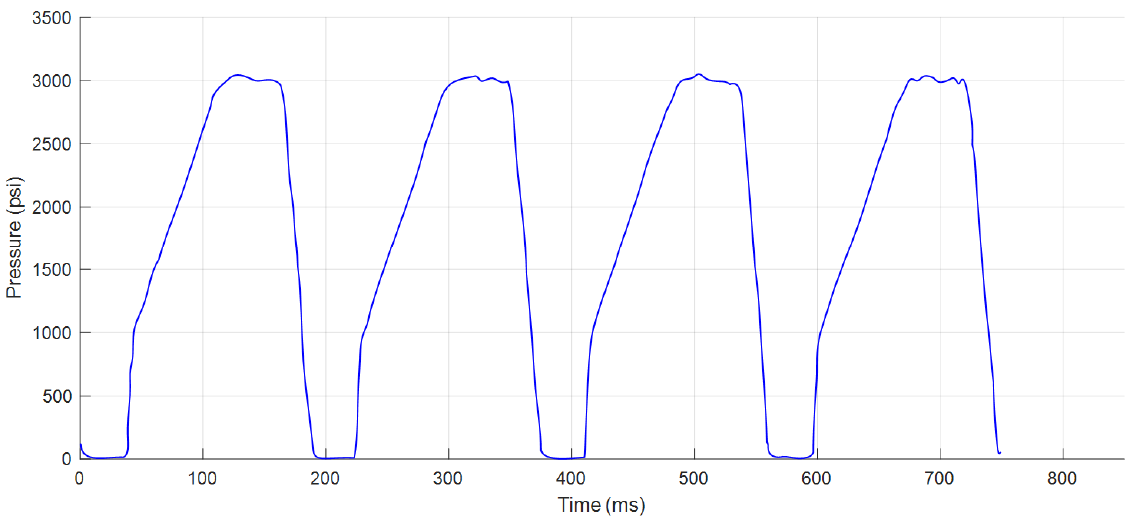
Figure 5. Pressure fatigue samples.